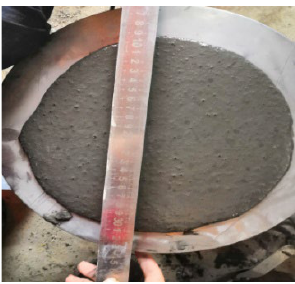
Figure 3. Liquidity test.